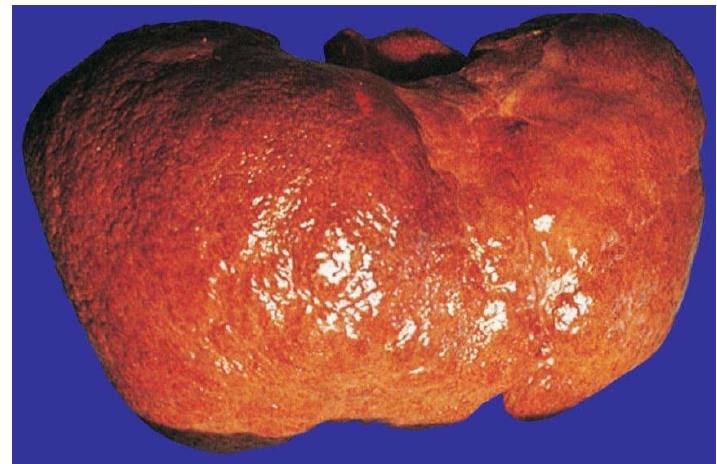
Figure 19. Macroscopic picture of alcoholic cirrhosis. The surface of alcoholic cirrhosis is granular, reflecting the regenerative nodules, which can be seen upon histological evaluation.